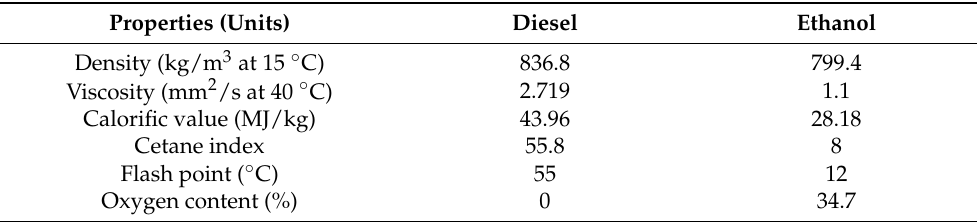
Table 1. Properties of neat diesel and